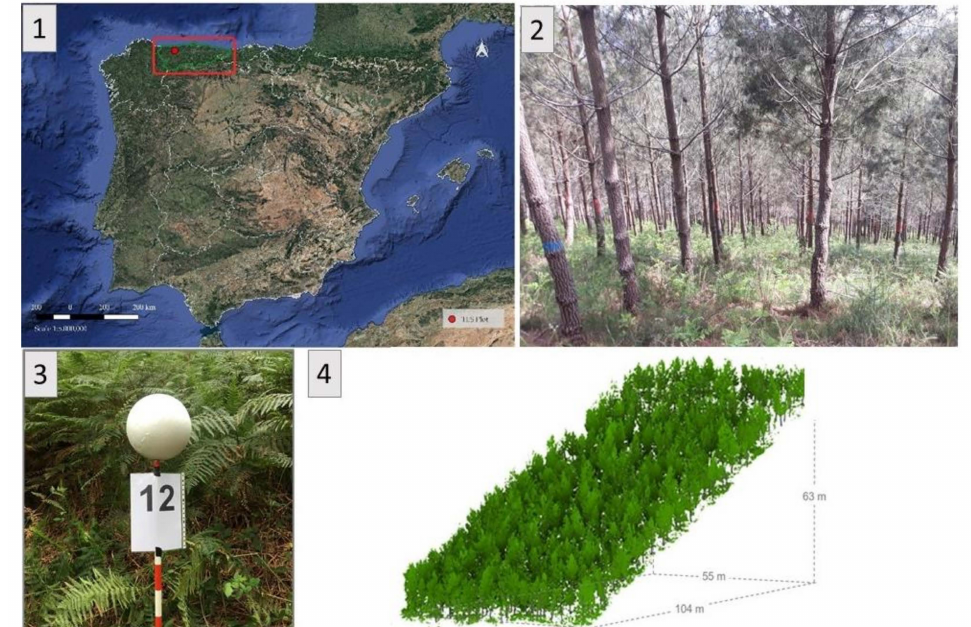
Figure 1. ( 1 ) Plot situation in northern Spain (Longitude 6 ◦ 32 (cid:48) 33.25” Latitude 43 ◦ 25 (cid:48) 18.06”) ( 2 ) Pinus pinaster stand and understory within the plot. ( 3 ) Polystyrene spheres used for the point cloud georeferentiation. ( 4 ) Three-dimensional representation of size and slope of the